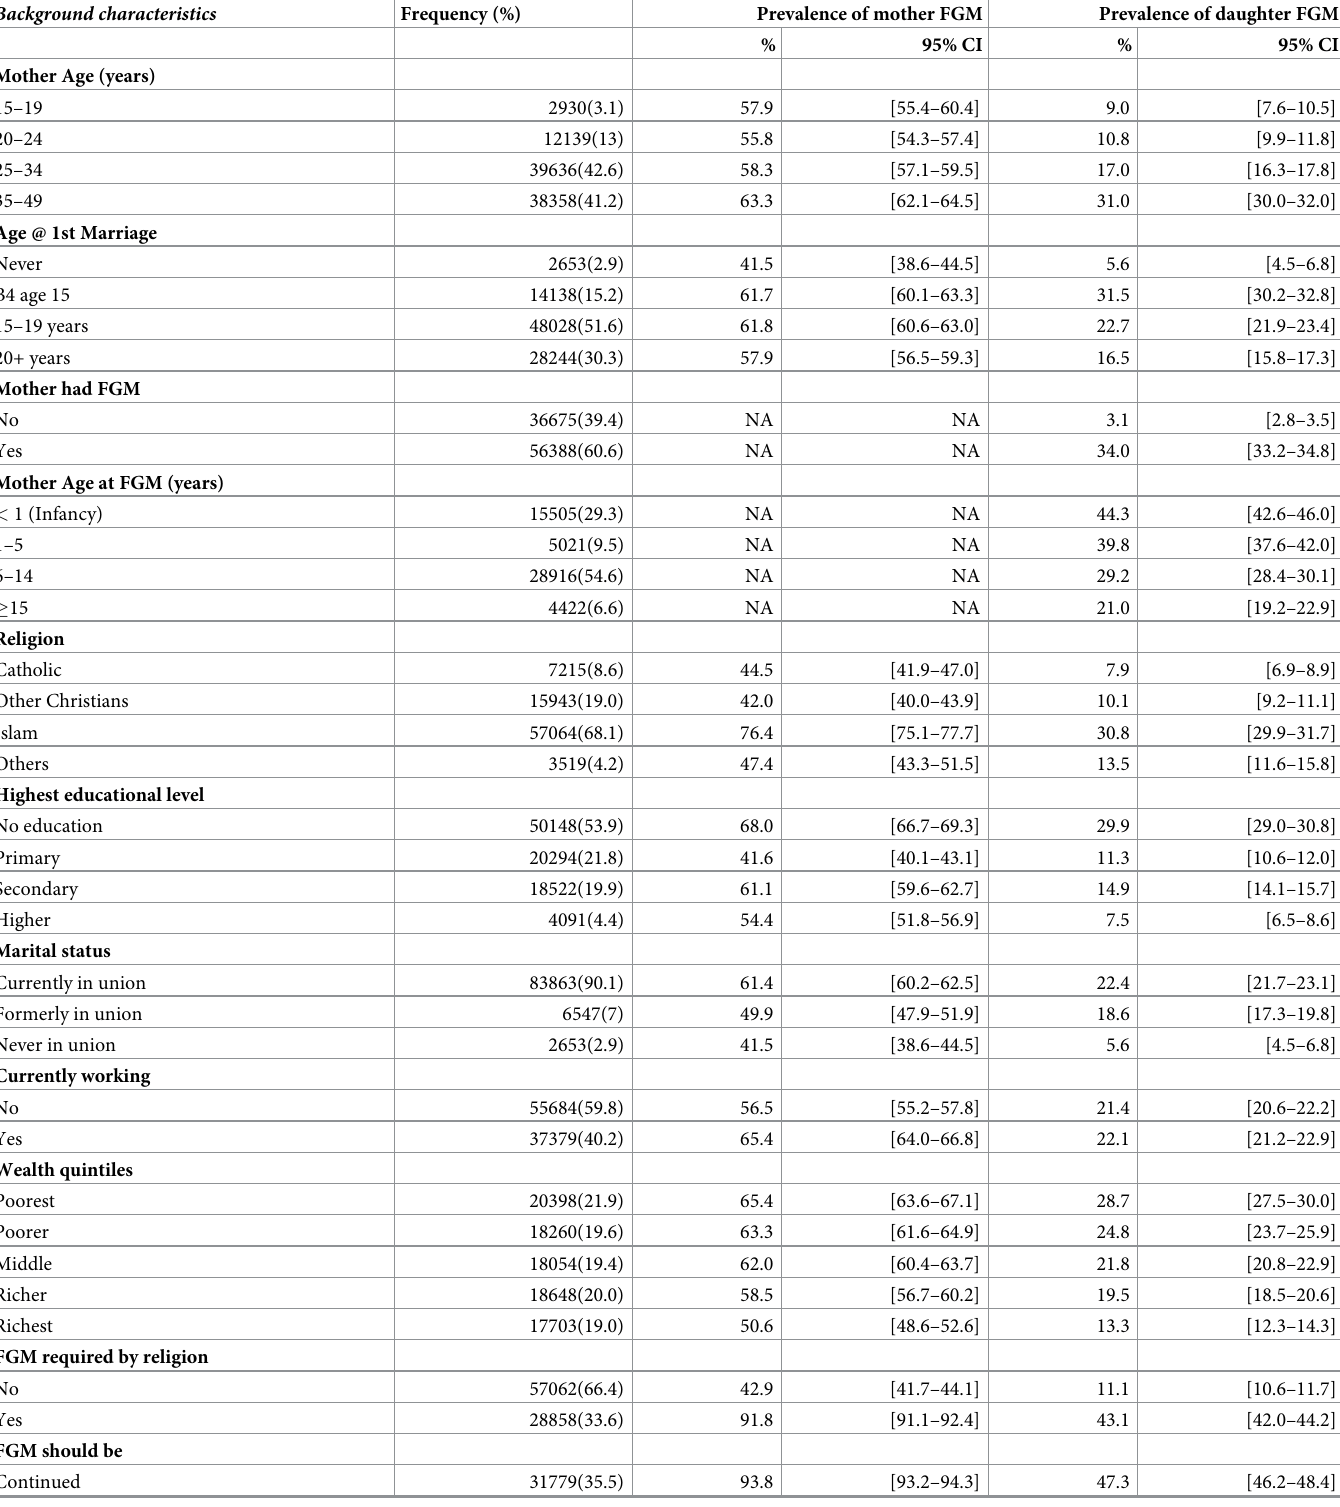
Table 2. Pooled descriptive characteristics of study